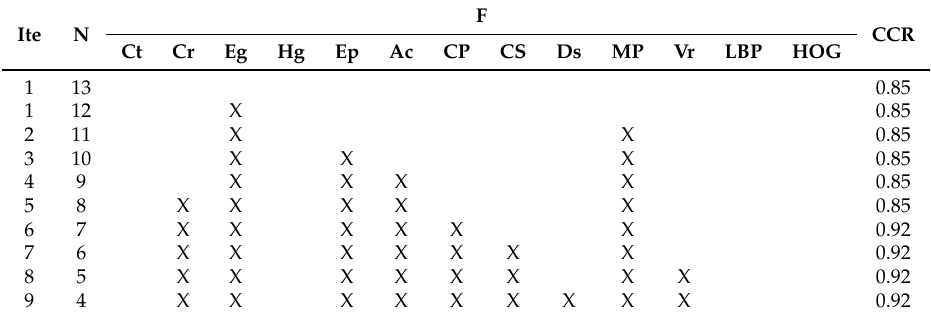
Table 5. Intra-modal selection of texture features. Correct classification rates obtained when applying the proposed selection process on breast MRI texture features. Ite: iteration. N: number of features kept. F: features. CCR: correct recognition rate.